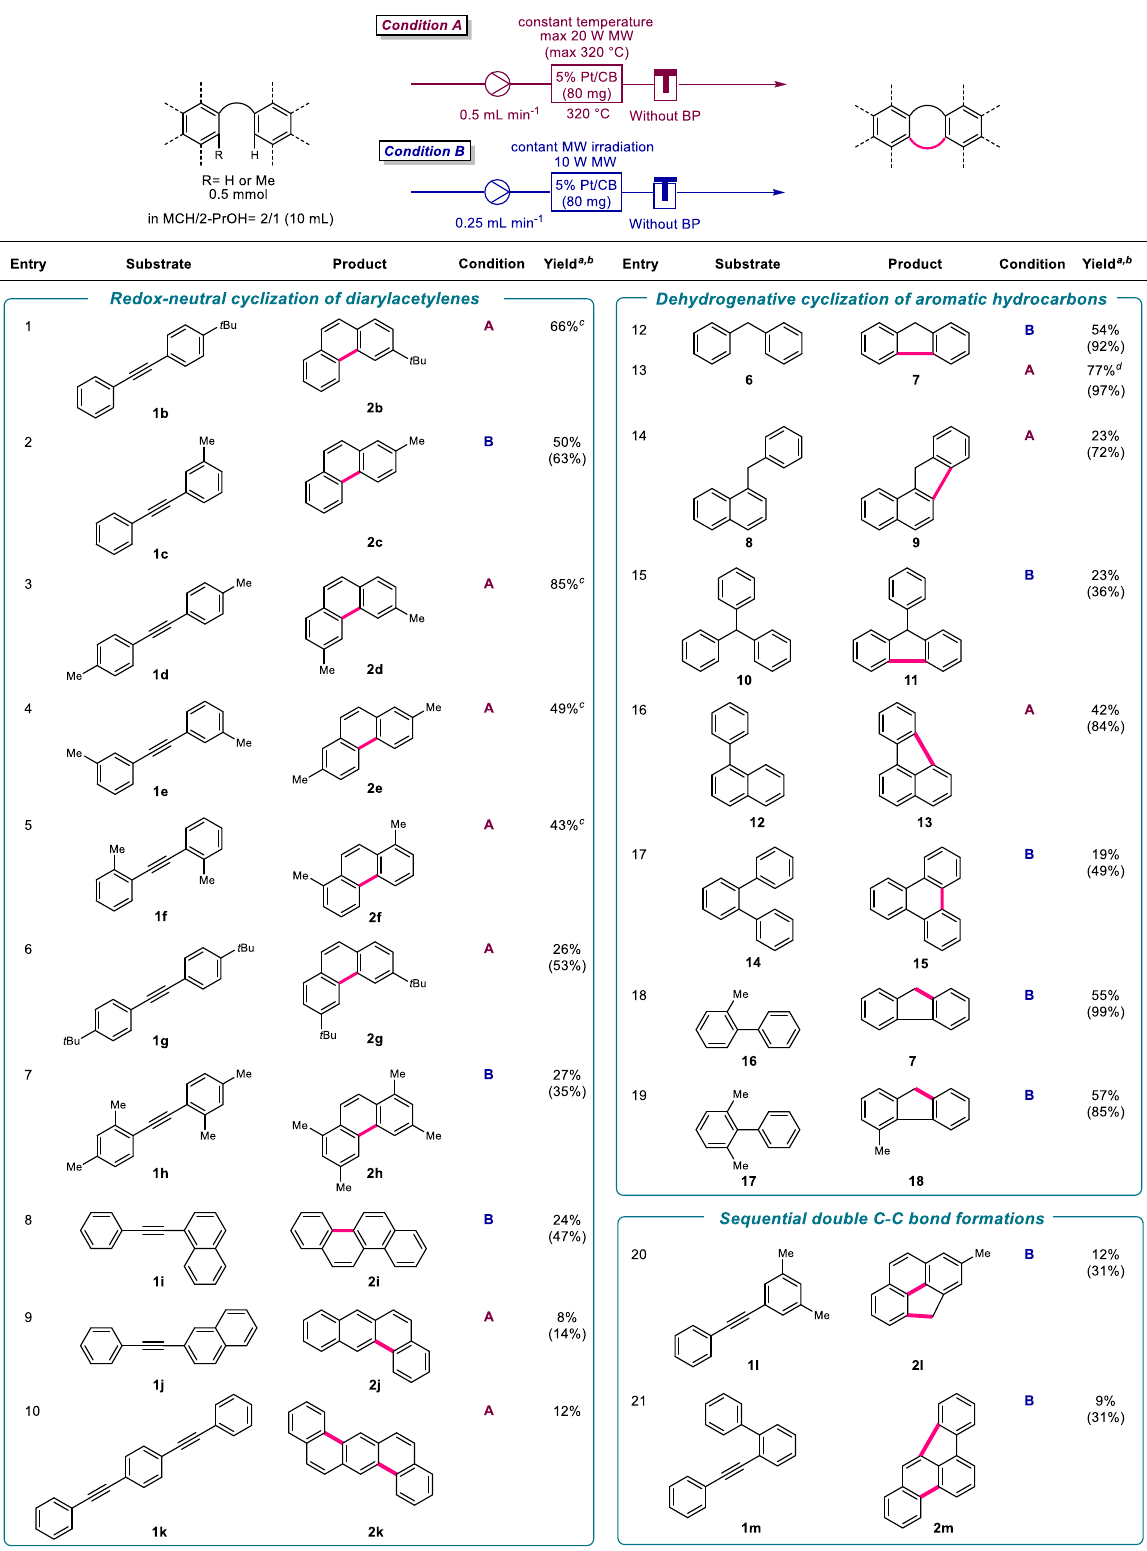
Fig. 6 Scope of substrates. a The yield was determined by 1 H NMR spectroscopy using 1,1,2,2-tetrachloroethane as an internal standard. b The yield based on the consumed starting material is in parentheses. c The starting material was completely consumed. d The fl ow rate was 0.25 mL min − 1